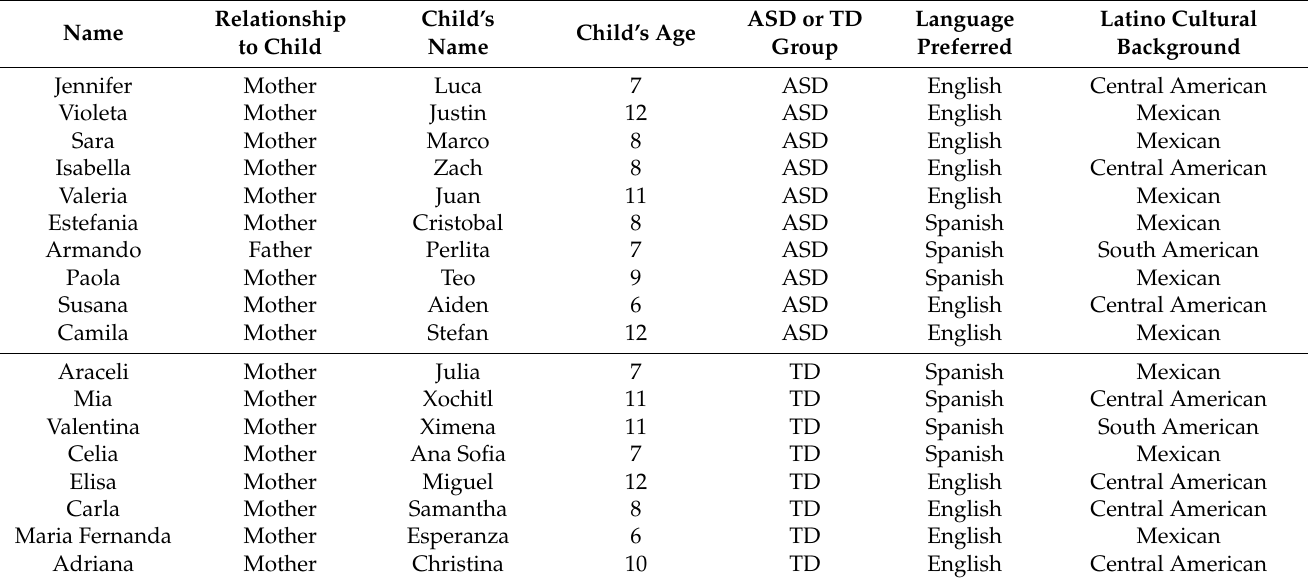
Table 2. Participant Demographics (Participants are identified by pseudonyms to protect